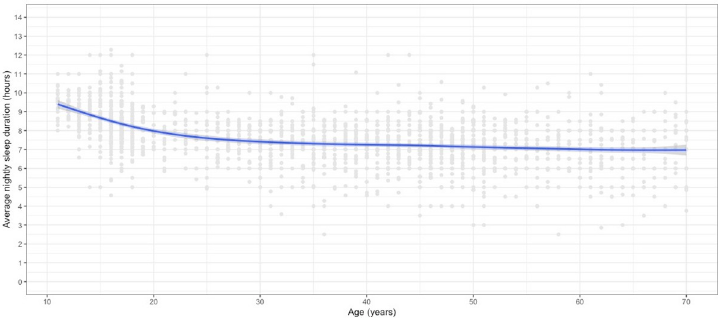
Fig 1. The unadjusted relationship between sleep and age, across all age groups (95% CI shown in grey).